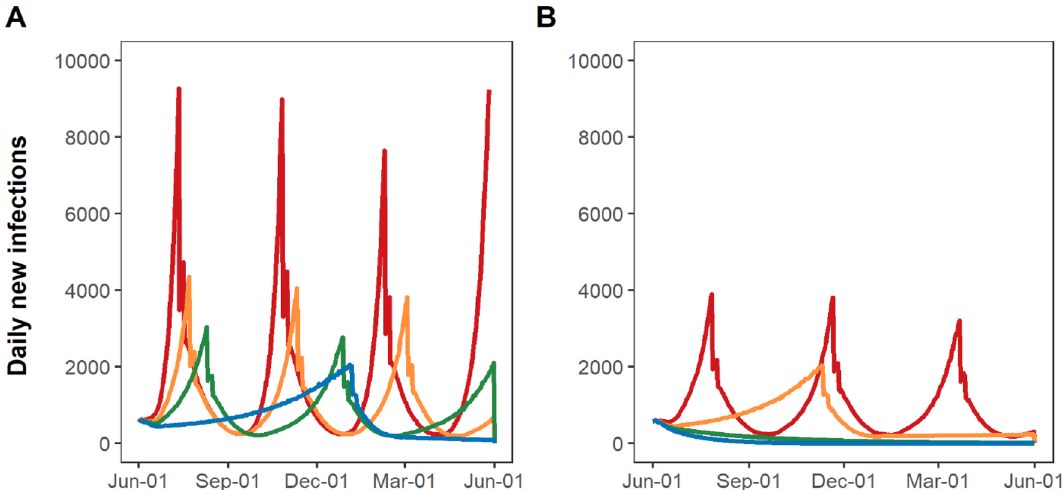
Figure 2. Daily COVID-19 new infections under resumption and relaxation of restrictions between June 2020 and May 2021: ( A ) without adherence to social distancing and ( B ) with 50% adherence to social distancing. Each colored line indicates the level of mask adherence at 0% (red), 50% (orange), 70% (green) or 90% (blue).